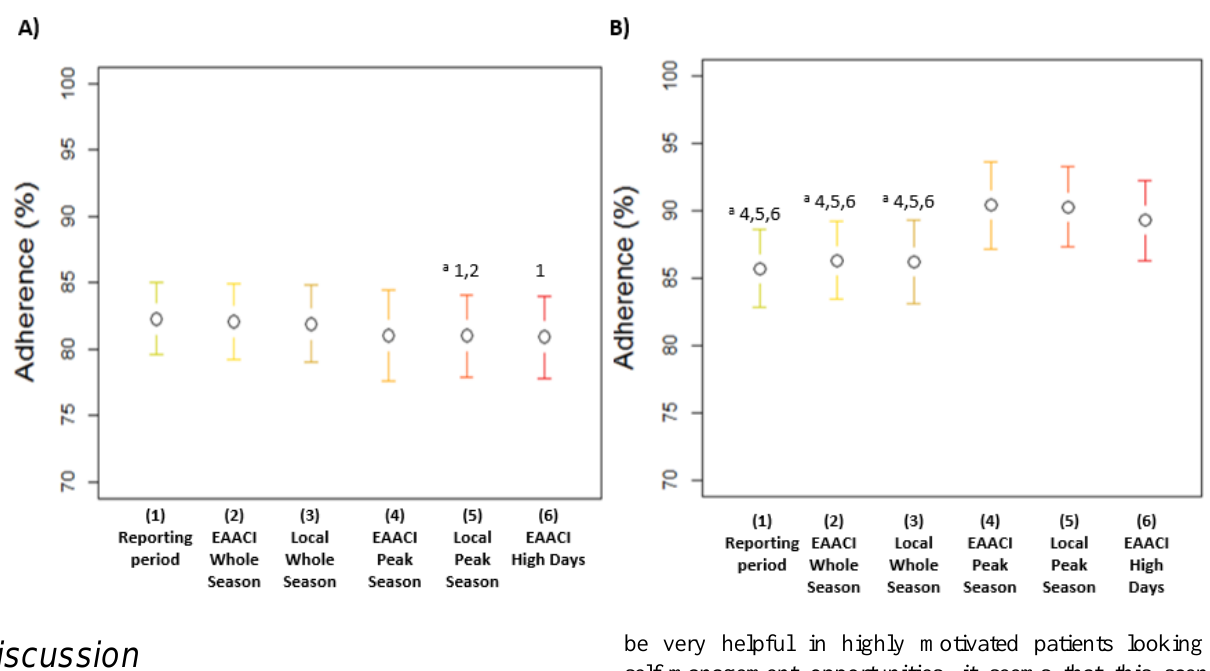
Figure 6. Mean (95% CI) adherence to recording of the e-diary during the pollen season in children affected by seasonal allergic rhinitis in (A) Rome and (B) Pordenone. Adherence was calculated for each patient considering the total reporting period and according to whole, peak, and high days of pollen periods defined by the European Academy of Allergy and Clinical Immunology (EAACI) and local criteria. See Figure 1 and Table 2 for criteria. "a" indicates that nonparametric Friedman test for repeated measures was applied and only statistically significant P values of multiple comparisons, adjusted by Bonferroni correction, are